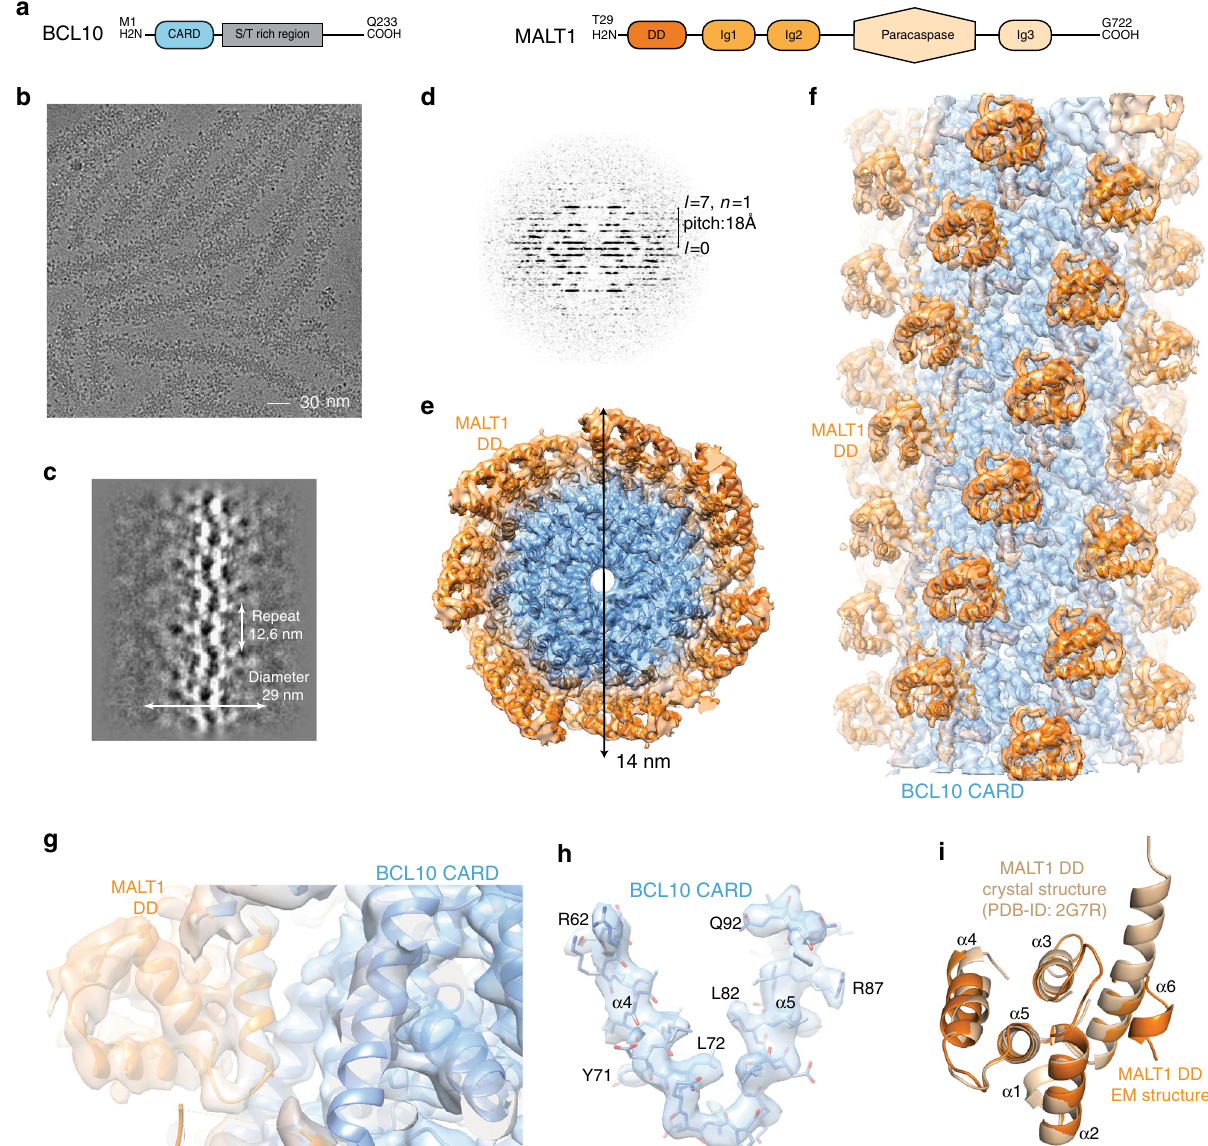
Fig. 1 Cryo-EM reconstruction and atomic model of the BCL10-MALT1 fi lament. a Domain organization of the BCL10 and MALT1 protein constructs. b Example cryo-EM micrograph of the BCL10-MALT1 complex fi laments. c , d 2D class averages and corresponding power spectra of BCL10-MALT1 fi laments used for helical parameter determination. e , f Overall architecture of the BCL10-MALT1 fi lament assembly shown together with the cryo-EM density, clipped top and side view, respectively. The map shows the inner well-structured part of the fi lament at an overall resolution of 4.9 Å (FSC curve see Supplementary Fig. 8a). This part consists of the BCL10 CARD (residues 10 – 115) and the MALT1 DD (residues 30 – 121) colored blue and orange, respectively. g , h Example parts of the cryo EM density map shown together with the BCL10-MALT1 DD and the atomic model of BCL10 shown in ribbon and stick representation, respectively. i Overlay of the MALT1 DD cryo-EM and crystal structure (pdb ID: 2g7r) colored orange and beige,